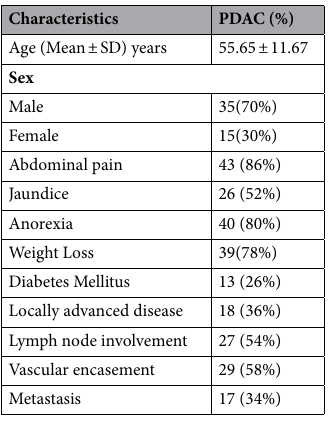
Table 6. Clinical characteristics of the PDAC patients (n =